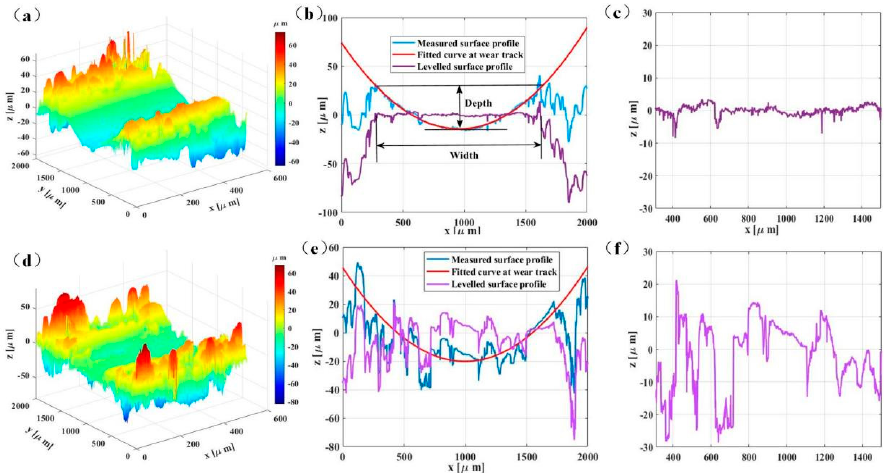
Figure 7. Three − dimensional morphologies ( a , d ), cross − sectional profiles ( b , e ), and leveled curves ( c , f ) of wear tracks of pure PA12 and SiC/PA12 composite.